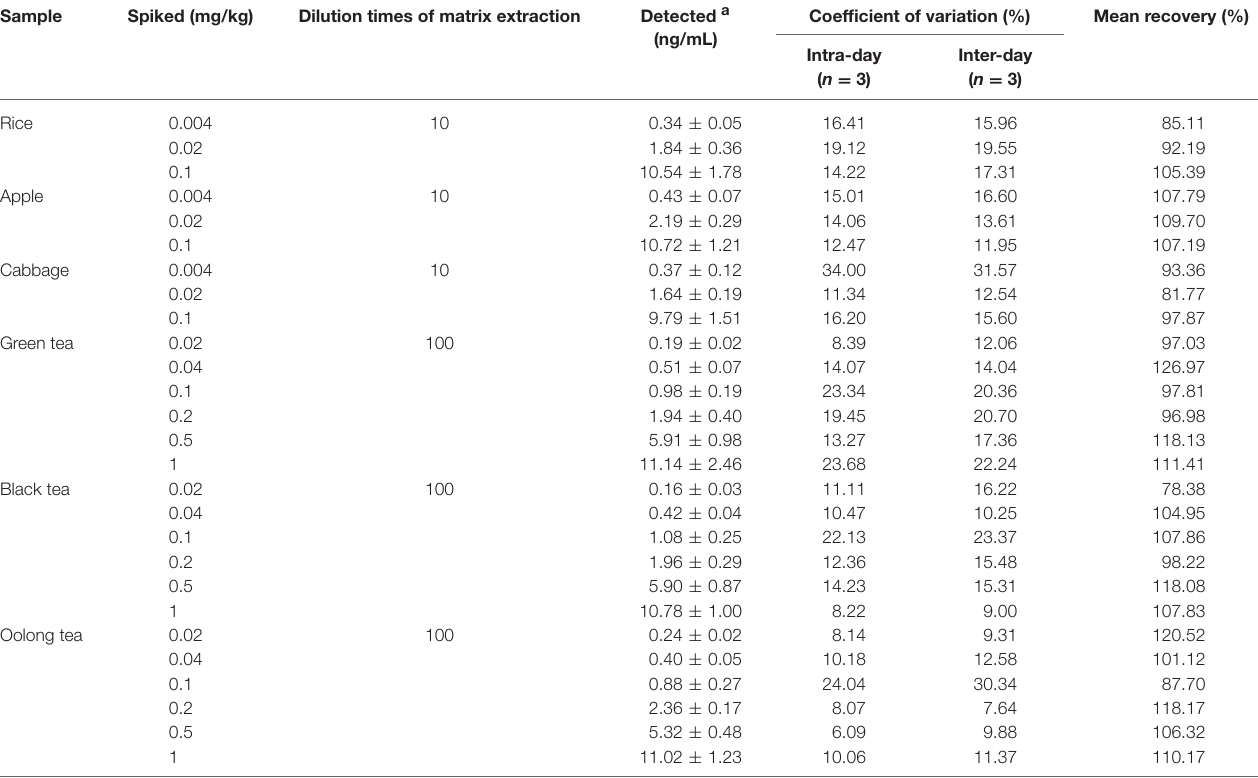
TABLE 3 | Recovery of acetamiprid in spiked samples by QDs-ICS. Sample